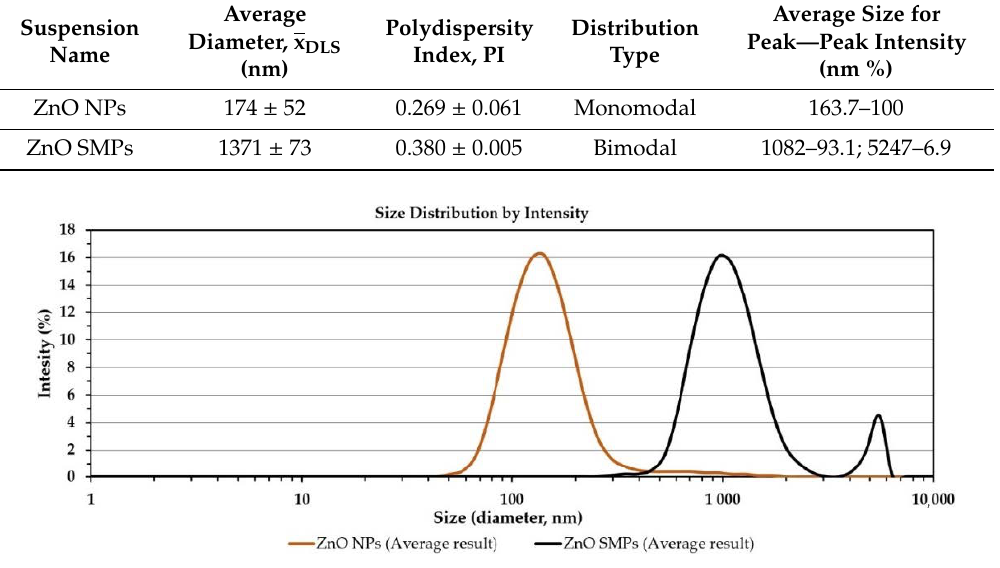
Figure 4. Particle size distributions of ZnO in suspensions with the concentration of 100 ppm (dynamic light scattering (DLS) method).